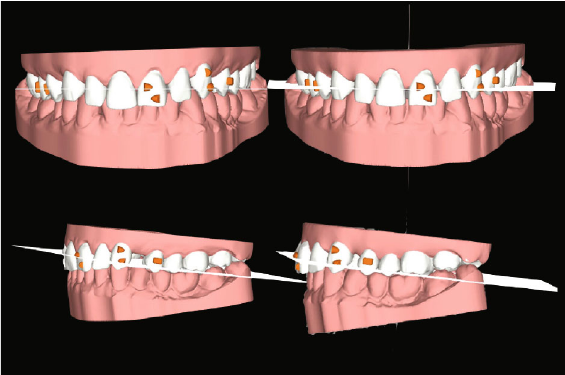
Figure 7: Final teeth